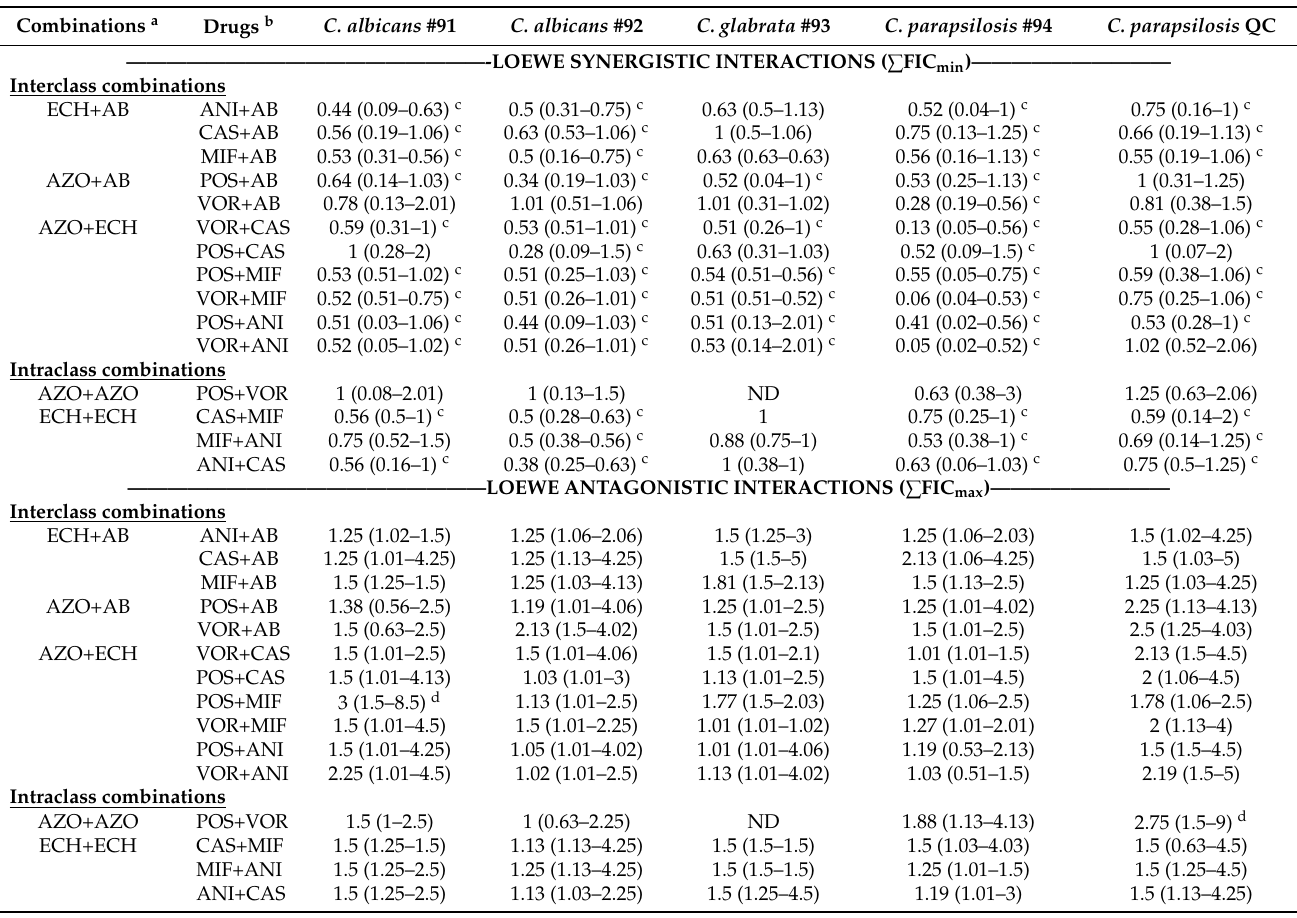
Table 2. Results of the Loewe additivity-based FICi index analysis of two-drug combinations between echinocandins, azoles, and amphotericin B obtained from the 6 centers for each of the 5 Candida isolates